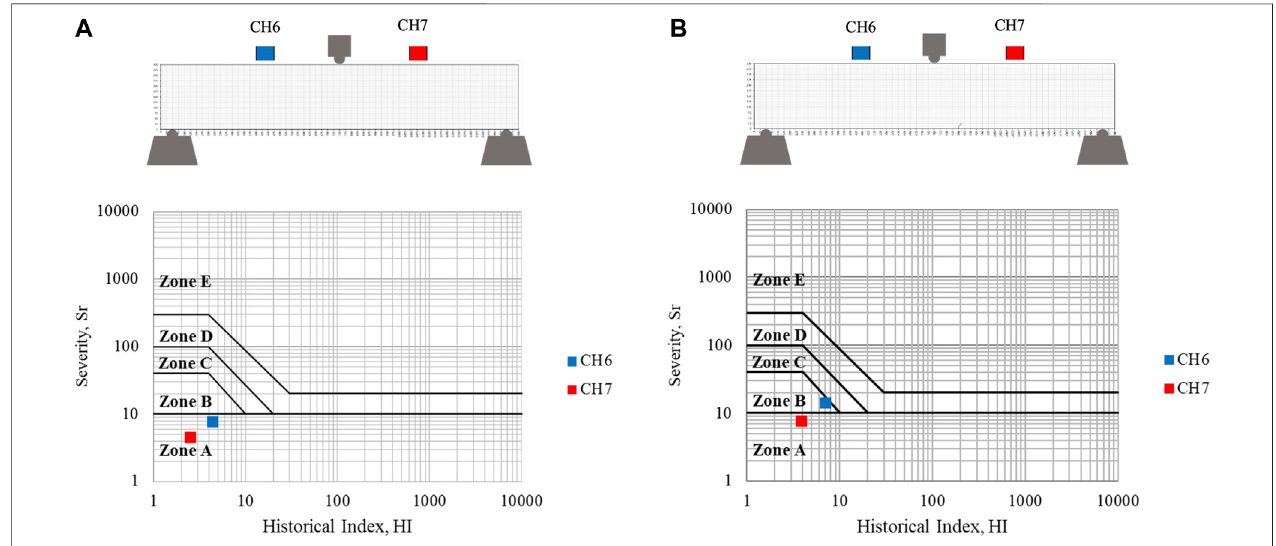
FIGURE 12 | The crack zones obtained from CH6 and CH7 for beam S2B (A) CM1 and (B) CM2.